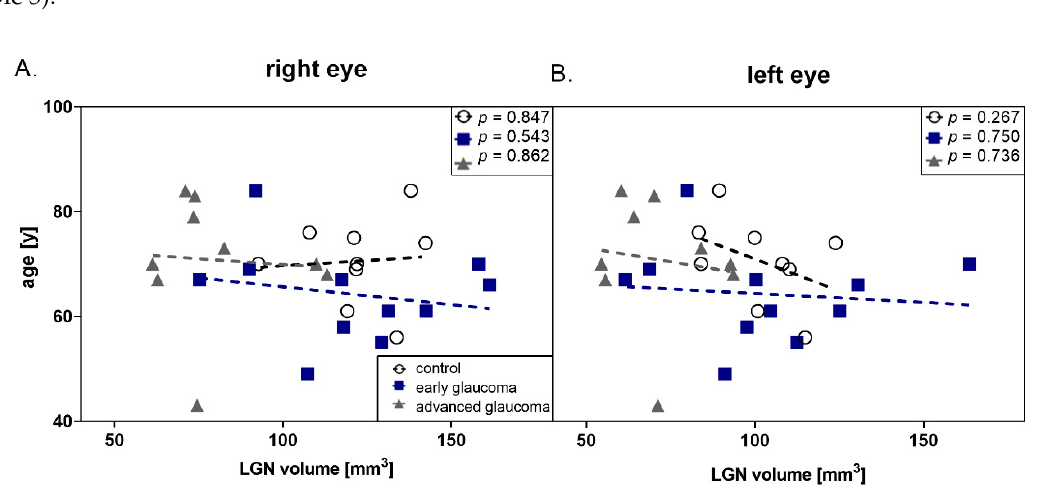
Figure 2. Correlation between age and lateral geniculate nucleus (LGN) volume in all groups (black dot—control; dark blue square—early glaucoma, gray triangle—advanced glaucoma) ( A ) right eye ( B ) left eye.